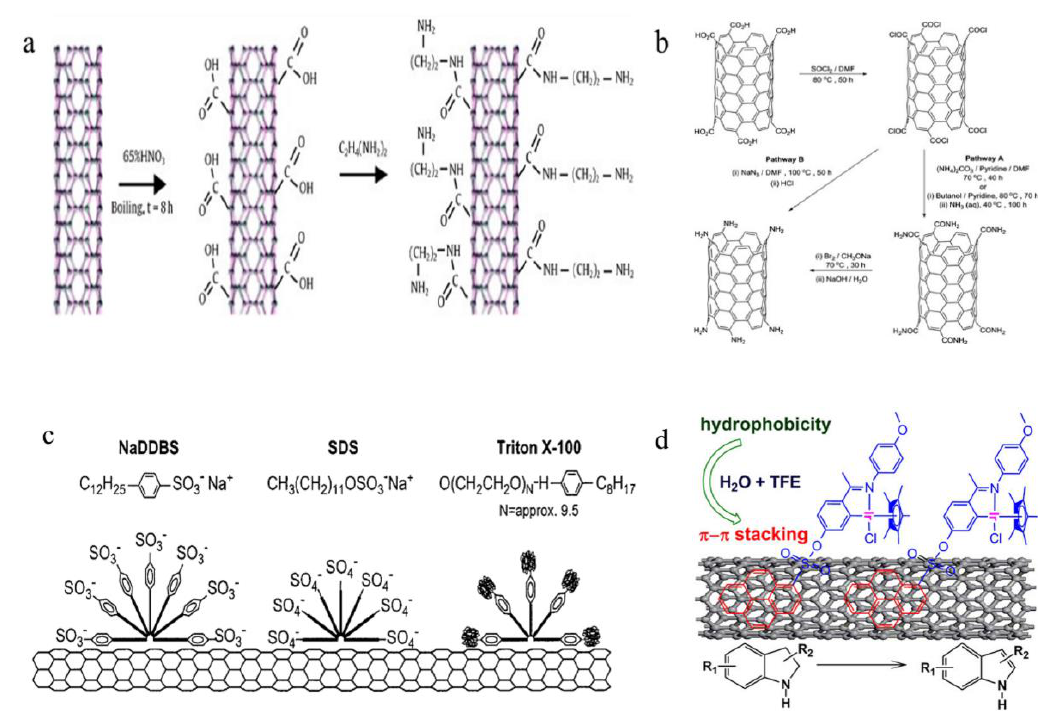
Figure 3. Covalent ( a , b ) and the non-covalent modifications ( c , d ) of carbon nanotubes. ( a ) Carboxyl functionalized carbon nanotubes. Reproduced from Phuong et al. [63] by permission of Elsevier Science Ltd. ( b ) Amino functionalized CNT. Reproduced from Campidelli et al. [64] by permission of Bentham Science Publishers.; ( c ) Iridium metal complex catalyst was coated on the surface of the carbon nanotubes through a non-covalent bond accumulation. Reproduced from Islam et al. [67] by permission of the American Chemical Society; ( d ) Diagram of the surfactant adsorption on the CNT surface. Reproduced from Cui et al. [68] by permission of Tech Science